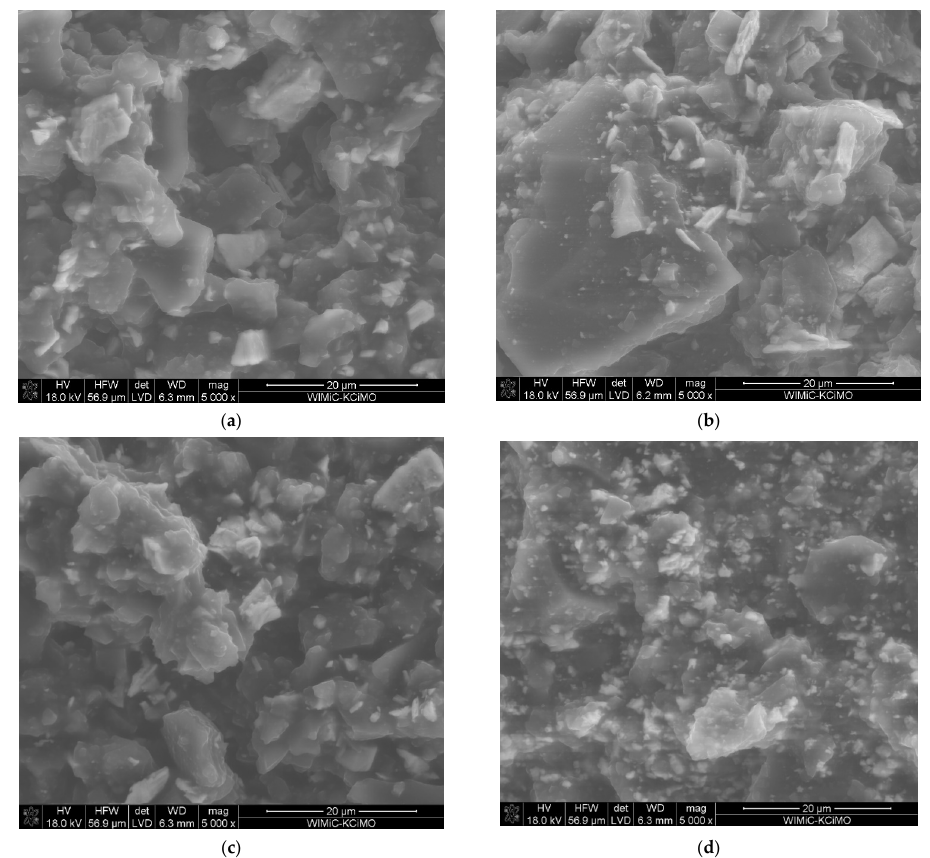
Figure 5. SEM micrographs of oxide modified GC n /PDMS paste electrodes taken at 5000× g magnification ( a ) Y 2 O 3 , ( b ) Yb 2 O 3 , ( c ) Y 2 O 3 , Yb 2 O 3 , and ( d ) La 2 O 3